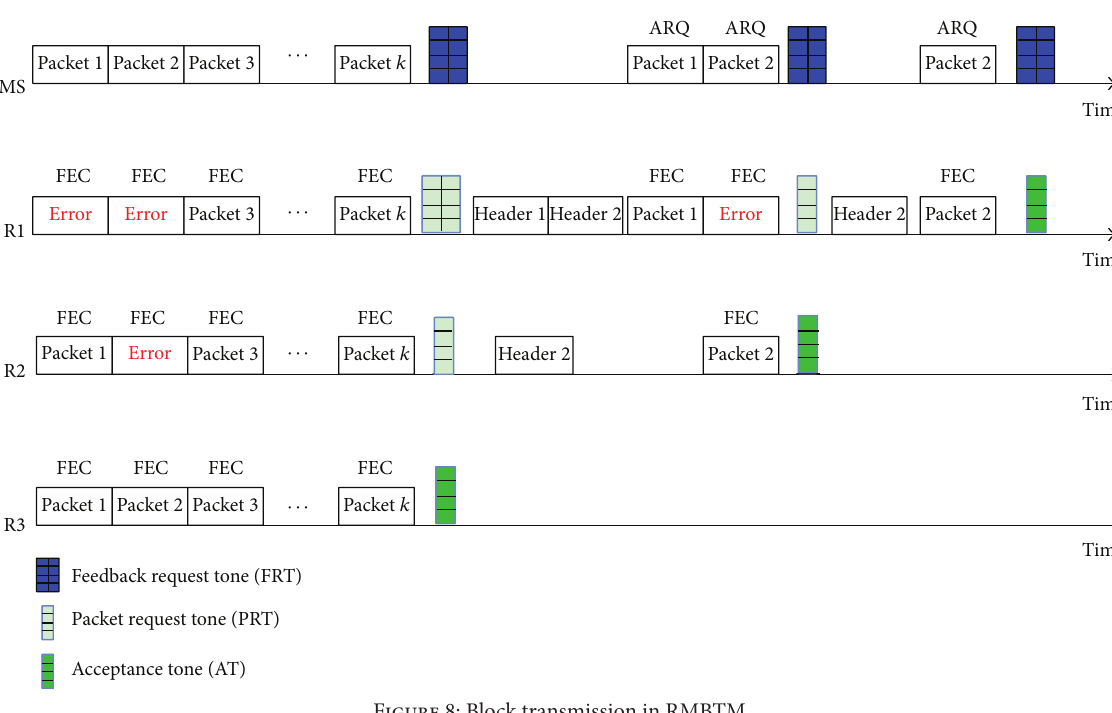
Figure 8: Block transmission in